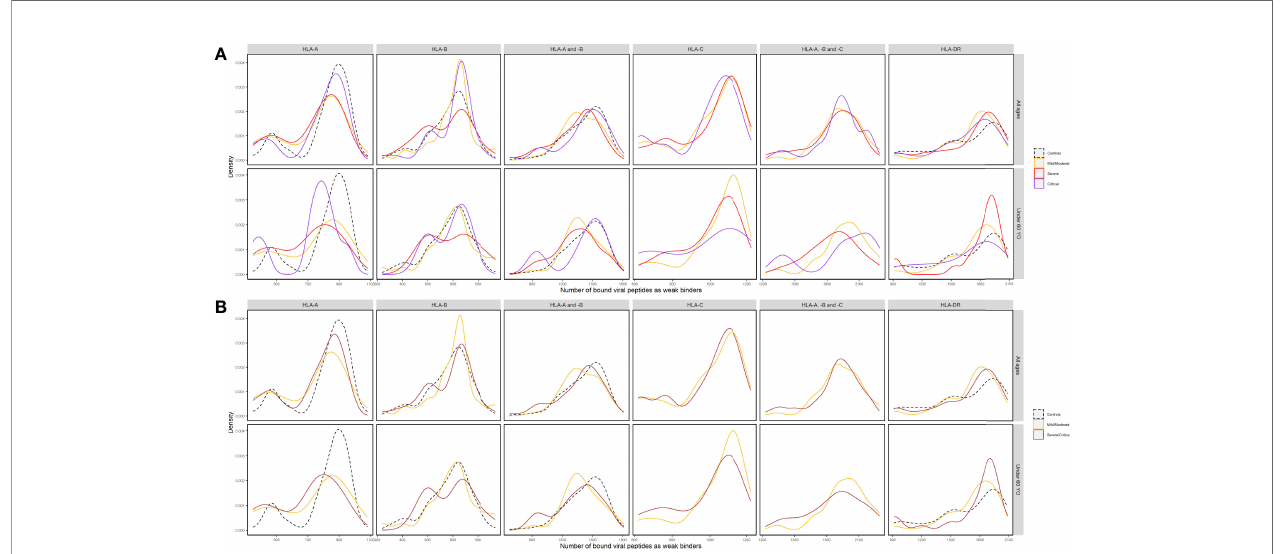
FIGURE 4 | Density distributions of the numbers of SARS-CoV-2-derived peptides predicted by %Rank as as weak binders to HLA-A (n A ), HLA-B (n B ), HLA-A and -B (n AB ), HLA-C (n C ), HLA-A, -B and -C (n ABC ), and HLA-DR (n DR ) molecules (A) in three subgroups of patients (Mild/Moderate: solid curves in yellow; Severe: solid curves in red; Critical: solid curves in purple) and controls (dashed curves in black) and (B) in two subgroups of patients (Mild/Moderate: solid curves in yellow; Severe/Critical: solid curves in rose) and controls (dashed curves in black) of all ages and in those under 60 years old, respectively. Note that n C and n ABC data were not available for controls.